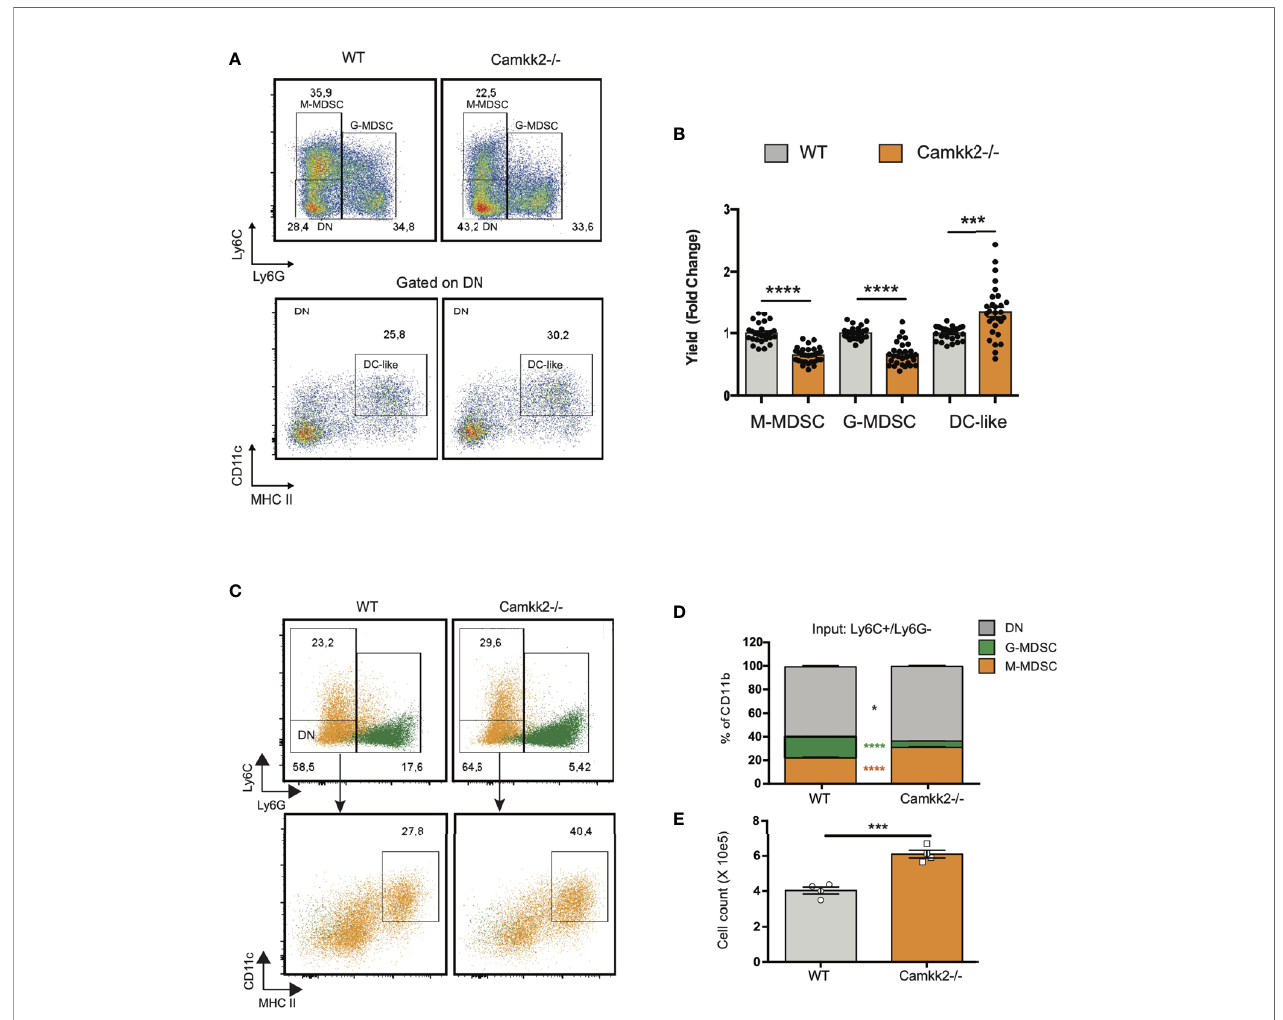
FIGURE 5 | Deletion of Camkk2 accelerates the terminal differentiation of MDSCs. Bone marrow cells from WT and Camkk2 -/- mice were cultured with GM-CSF/IL6 cytokines in the absence or presence of E.G7-OVA tumor conditioned medium (30% v/v). After 4 days, cells were collected, stained, and analyzed by fl ow cytometry. (A) Gating strategy and representative FACS pro fi les. (B) Yield of M-MDSC, G-MDSC and DC. Bar graph showing the cumulative results from 6 independent experiments and fold changes (FC) have been calculated on the yield of WT MDSC. (C, D) Bone marrow cells from WT and Camkk2 -/- mice were cultured with GM-CSF/IL6 cytokines in the absence or presence of E.G7-OVA tumor conditioned medium (30% v/v). After 4 days, non-adherent cells were collected and sorted by fl ow cytometry. Puri fi ed M-MDSC and G-MDSC were then cultured in the presence of GM-CSF/IL-6 and 30% of EG7 CM for additional 48 hours and analyzed by fl ow cytometry. (C) Gating strategy to identify M-MDSC, G-MDSC, and DC in M-MDSC and G-MDSC cultures. Overlapping dot plots refer to the FACS pro fi les of cells collected from M-MDSC and G-MDSC (shown in orange and green, respectively). (D) Percentage of M-MDSC, G-MDSC, and DN subsets (upper). (E) Yield of Ly6C- Ly6G- CD11c + MHC II + cells (namely DC). *, *** and **** refer to p<0.05, 0.005 and p < 0.001,